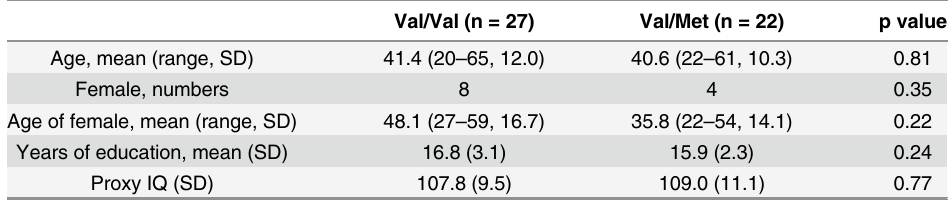
Table 1. Demographic Characteristics of Participants.